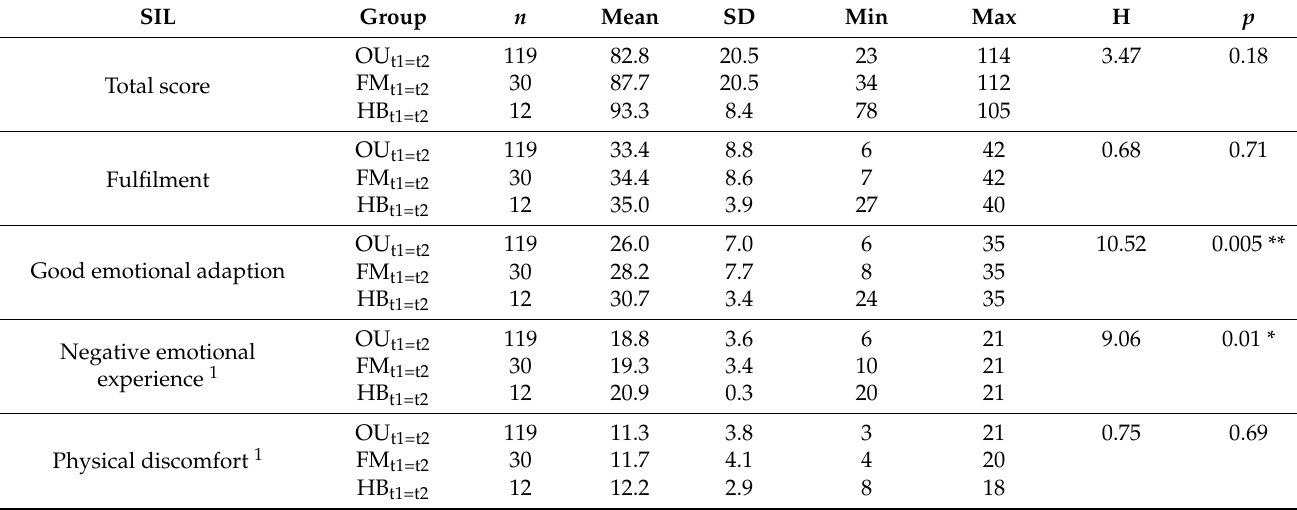
Table 3. Association between birth experience and actual birthplace, for women who gave birth at planned